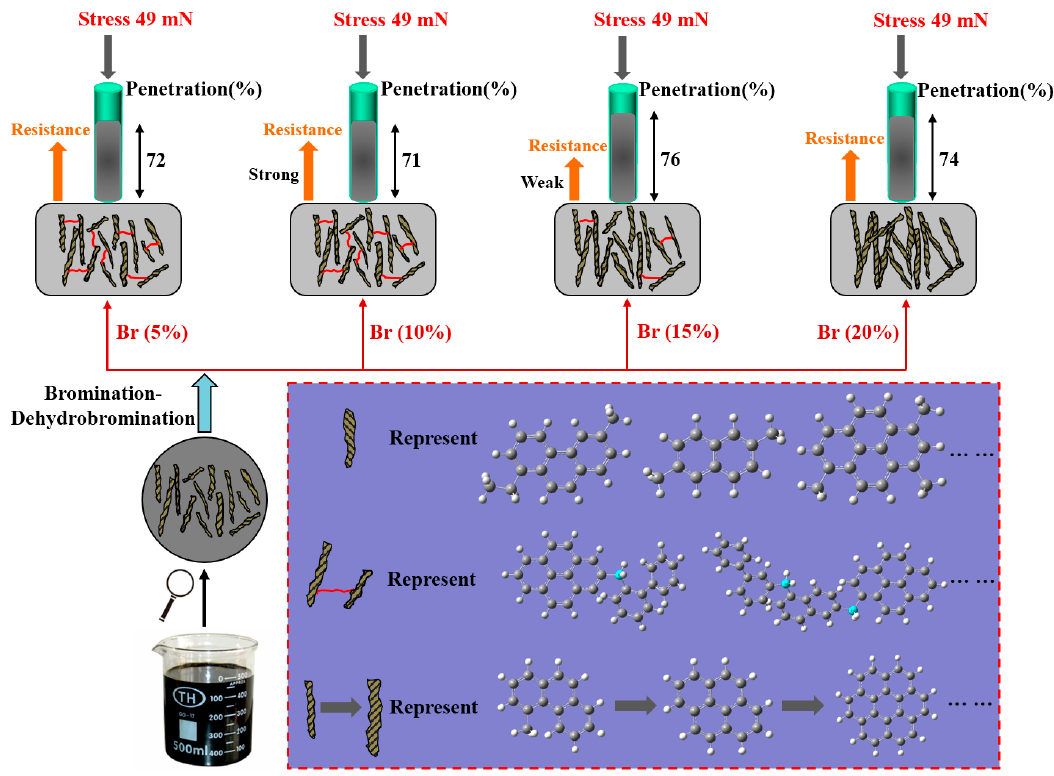
Figure4. E ff Figure 4. Effects of bromination-dehydrobromination on the microstructure of isotropic pitch precursors.